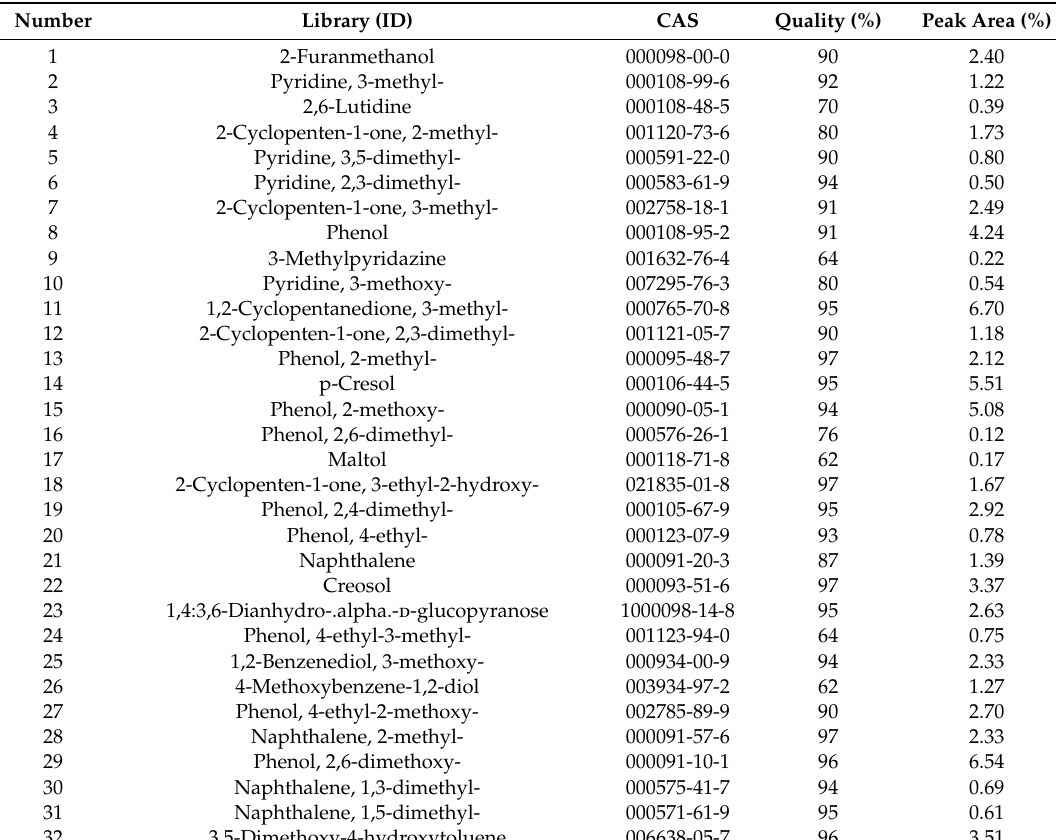
Table 6. The main components of bio-oil analyzed by